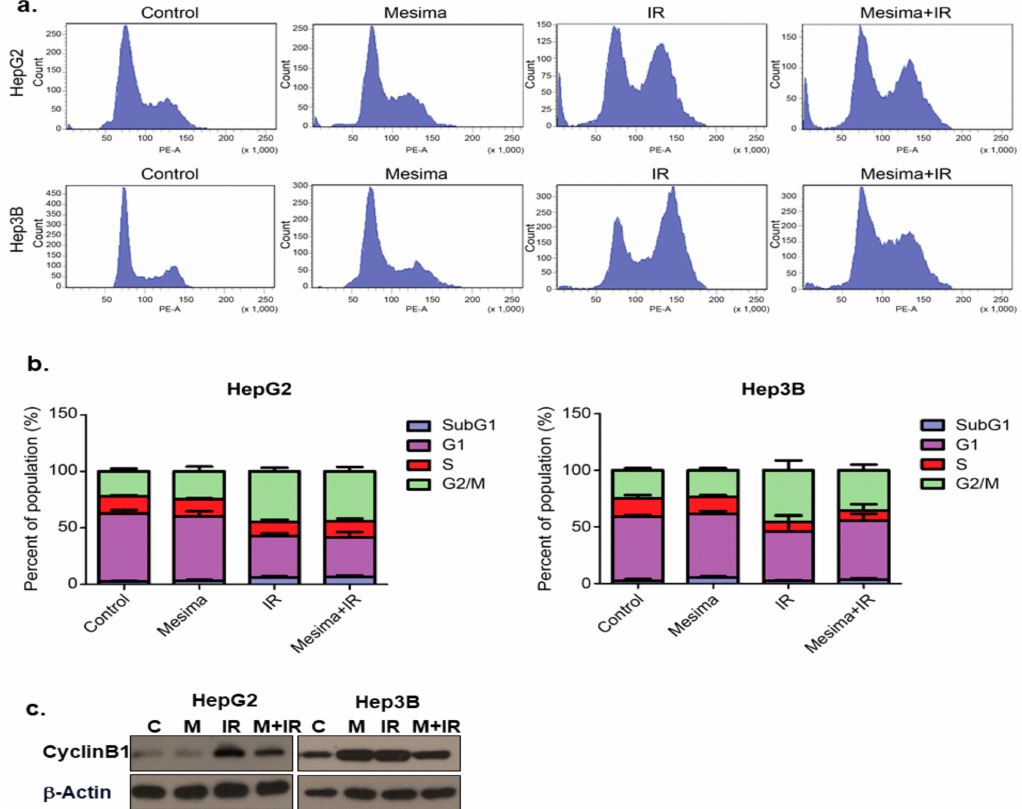
Figure 2. Mesima blocked cell cycle progression in the G2-M phase of irradiated cells and modulated the expression of cell cycle regulators. ( a ) E ff ects of mesima + radiation on cell cycle phase distribution. The two HCC cell lines were treated with a combination of mesima (1.25 mg / mL) and 6 Gy irradiation. After 24 h, the cell cycle distribution was analyzed quantitatively. Values represent the means of three experiments ± SE. ( b ) After 24 h, the cell cycle distribution was analyzed quantitatively. Values represent the means of three experiments ± SE. ( c ) Cyclin expression as analyzed by Western blotting. The two HCC cell lines were treated with radiation prior to mesima and were incubated for 24 h. Equal amounts of cell lysates (30 µ g) were separated by electrophoresis and analyzed by Western blotting, as